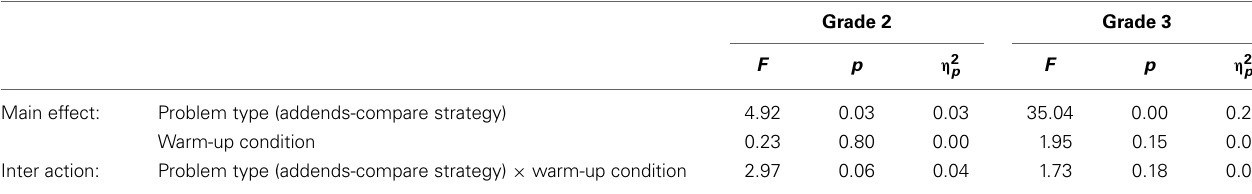
Table 5 | Results of the ANOVA problem type × condition separately for grade 2 and